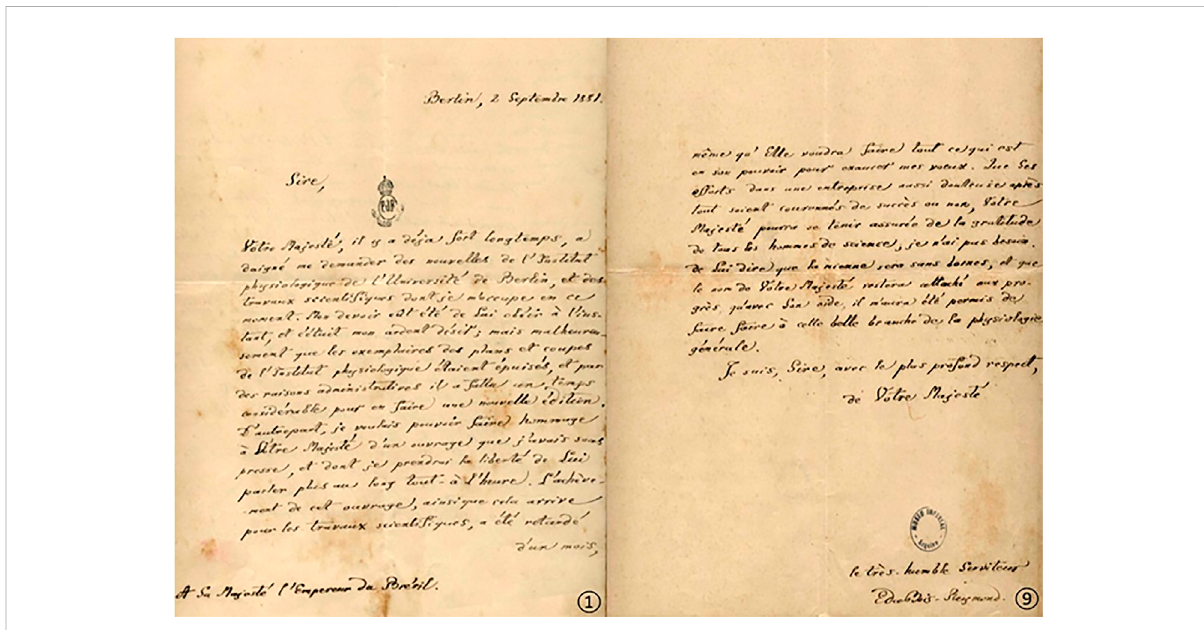
FIGURE 1 A letter from Bois-Reymond to Dom Pedro II, in 1881, about electric fi sh and his interest in contributing to the development of the Physiology LaboratoryoftheNationalMuseuminBrazil.EmileDuBois-Reymond,Germanphysicianandphysiologist(*7November1818,Berlin- † 26December 1896, Berlin, aged 78). Dom Pedro de Alcântara Bragança e Habsburgo (Rio de *Janeiro, 2 December 1825 — Paris, 5 December 1891, at the age of 66), the second and last Brazilian emperor, was a correspondent and partner of several international scienti fi c institutions, interacting with in fl uential scientists ofhistime in his ownor state interest (Gomes, 2021). Authorizedreproduction by Museu Imperial/Ibram/Ministério do Turismo/ no 02/2022 (Bois-Reymond,